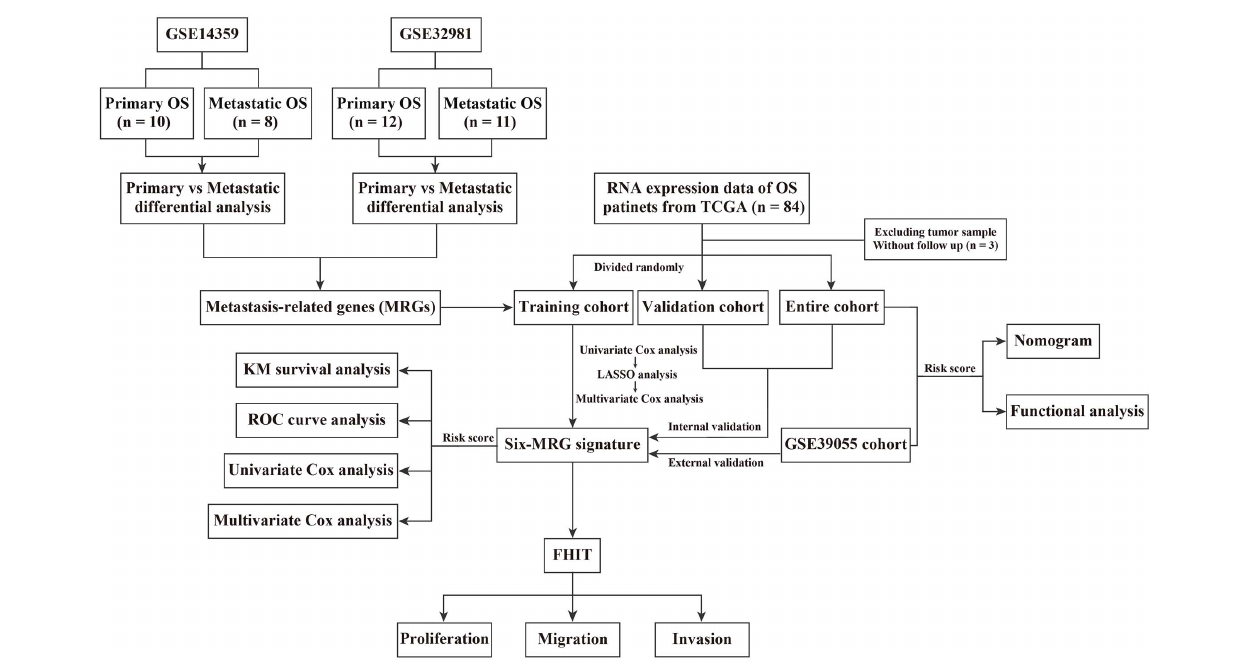
FIGURE 1 | Flowchart of the process used to derive the six-MRG signature and the survival